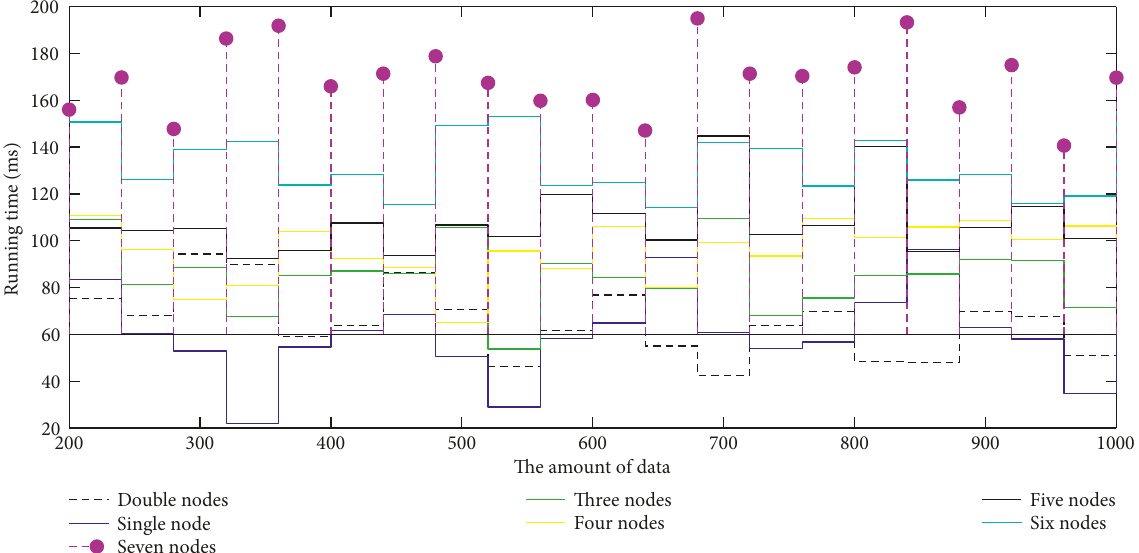
Figure 4: The running time of the improved algorithm for different data volumes.